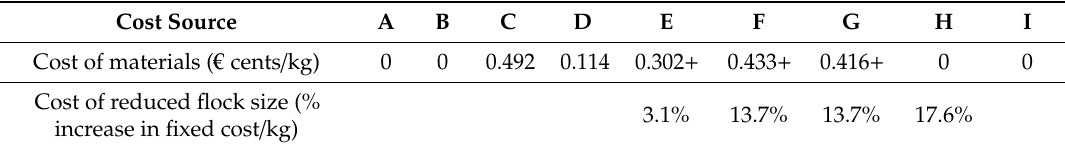
Table 2. Direct costs of each enrichment type applied in the